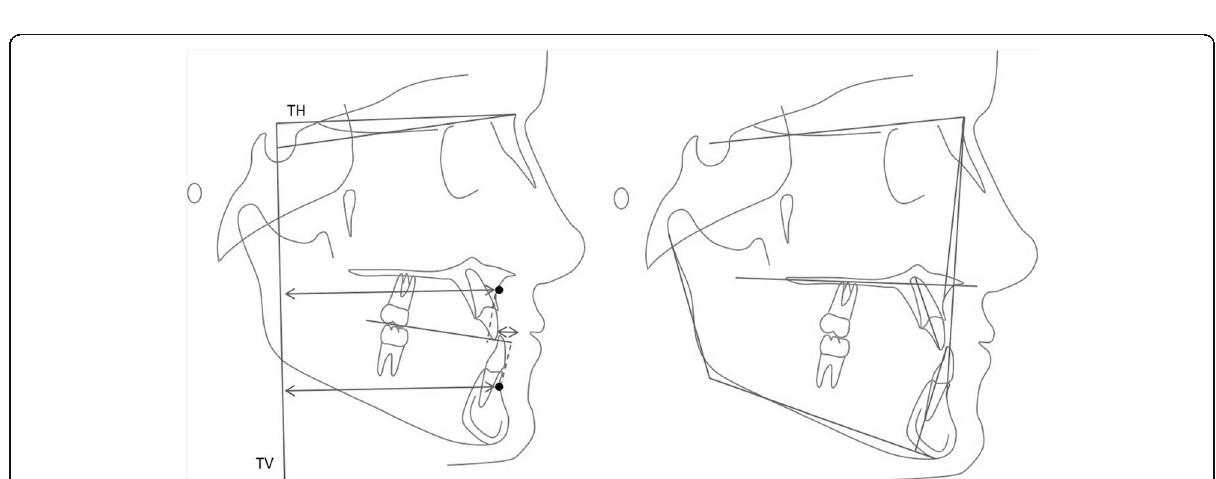
Fig. 5 Cephalometric analysis, left sagittal linear measurements (TH — true horizontal; TV — true vertical); right angular